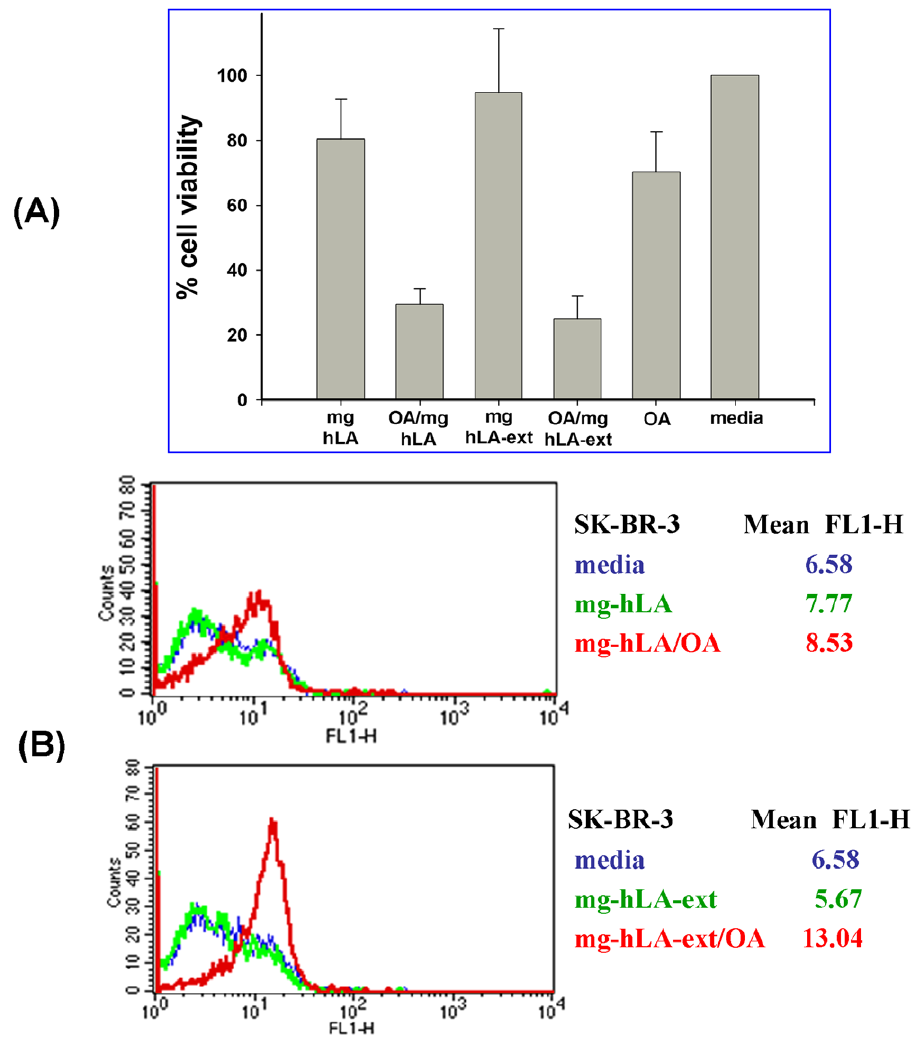
Figure 7. Measurement of tumoricidal activity during conversion of recombinant protein to tumoricidal complex. The effect on the cell viability of SK-BR-3 cells was studied after treatment with mg-hLA, mg-hLA/OA, and mg-hLA-ext and mg-hLA-ext/OA. The cells were incubated with molten globule proteins alone or complexed with OA, and their viability was investigated using Trypan blue (A) and by FACS analysis with Annexin V (B). When cells were incubated with the apo-form of hLA (mg-hLA and mg-hLA-ext), viability was comparable to the control (media alone) in the cell lines studied. When molten globule protein derived from hLA or hLA-ext was complexed with OA in a 1:10 ratio, viability of the cell lines SK- BR-3 was reduced. Results are shown as mean 6 SEM (*p ,